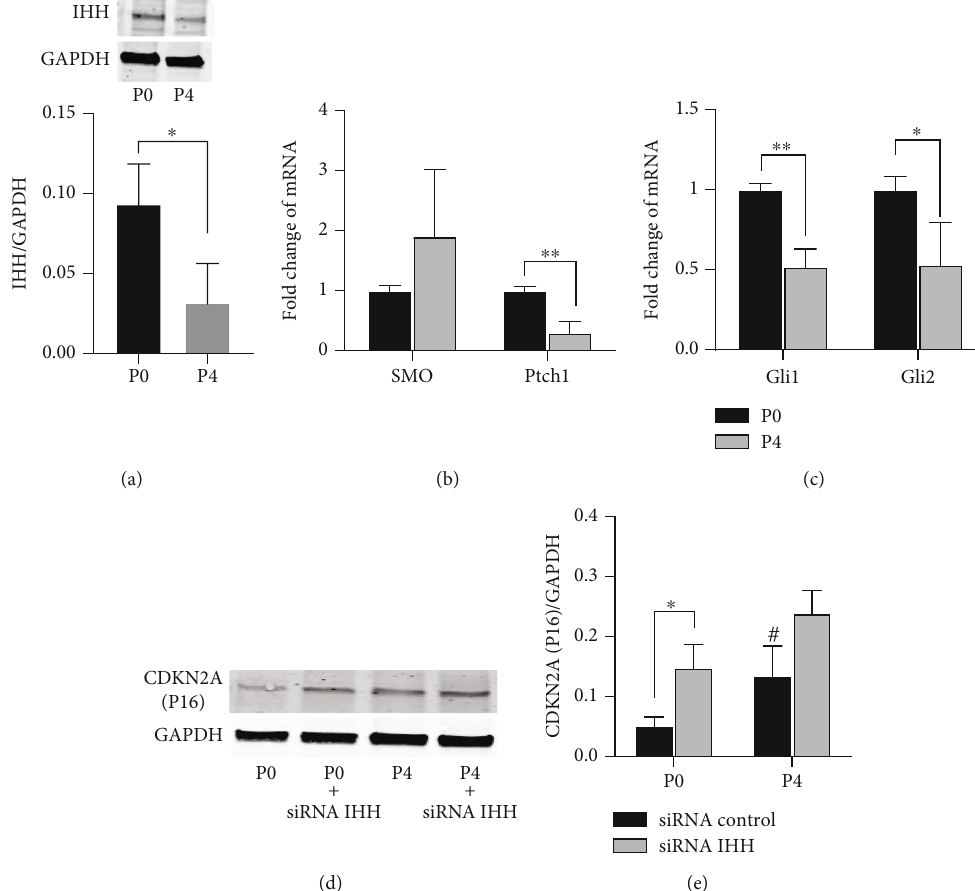
Figure 4: The associated inactivation of hedgehog signaling in senescent MSCs. (a) Blotting for IHH showing the decreased expression of IHH in P4 aged MSCs. PCR analysis indicated that expansion suppressed the gene transcription of Ptch-1 (b) and the transcription factors Gli1 and Gli2 (c). Suppression of the IHH expression by siRNA altered the CDKN2A expression. (d, e) Inhibition of the IHH increased CDKN2A protein expression and the di ff erence between P0 and P4 MSCs were abolished. ∗ p < 0 : 05 , Student ’ s t-test. # p < 0 : 05 versus the corresponding P0